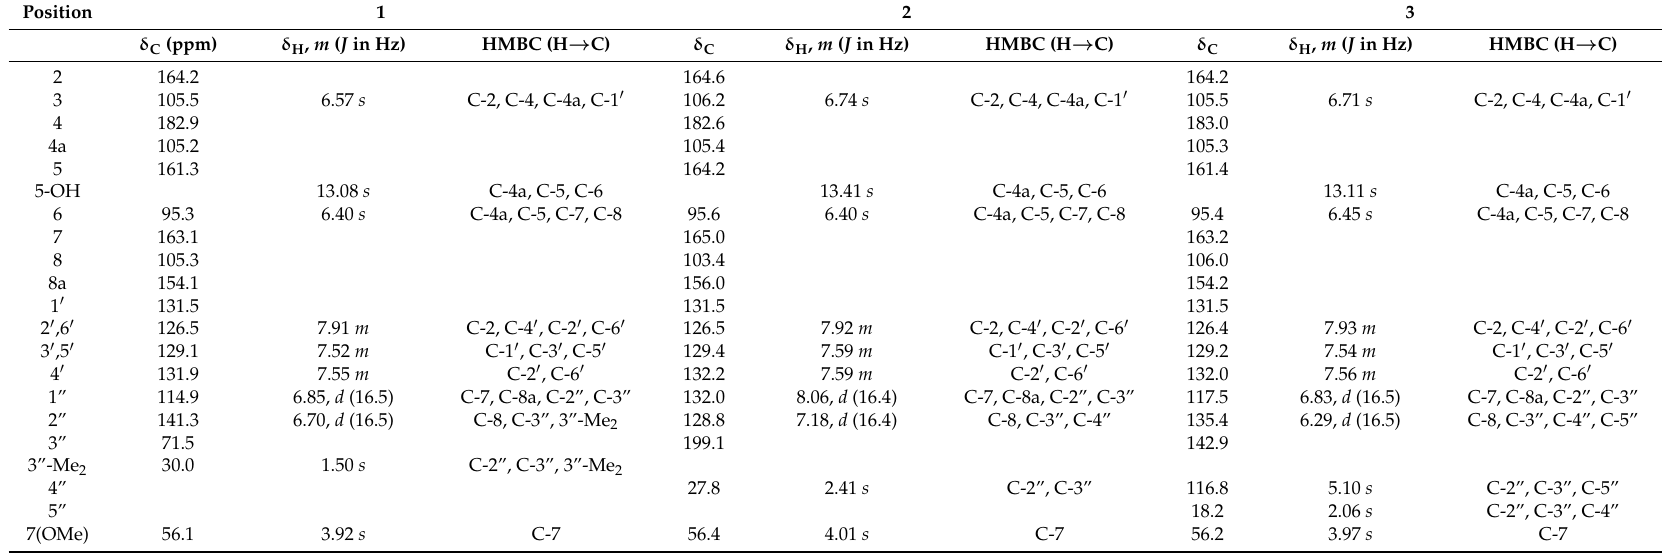
Table 1. 1 H- (800 MHz) and 13 C- (200 MHz) NMR data for compounds 1 , 2 , and 3 (in CDCl 3 ) at 25 ◦